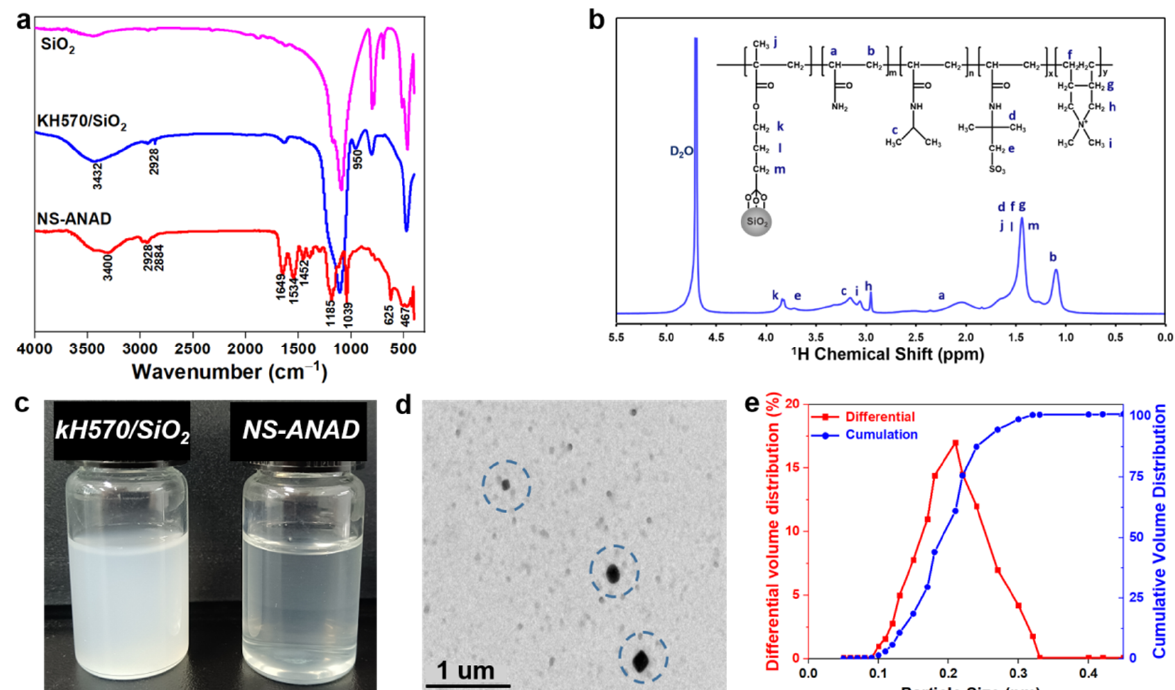
Figure 2. ( a ) FTIR of SiO 2 , KH570/SiO 2 , and NS-ANAD co-polymers. ( b ) 1 H NMR curves of NS- ANAD co-polymer. ( c ) 2 wt% aqueous solution of KH570/SiO 2 and NS-ANAD co-polymer. ( d ) TEM image of NS-ANAD co-polymer. ( e ) Particle size distribution of NS-ANAD co-polymer.